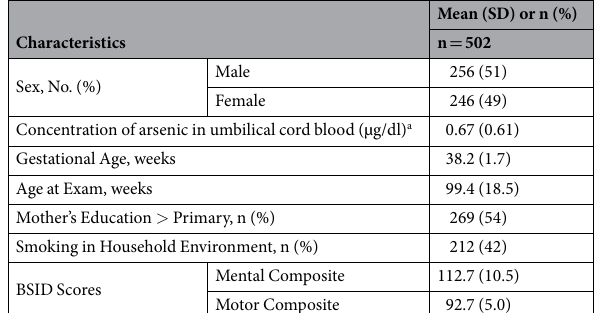
Table 1. Demographic, clinical, and neurological assessment data for Bangladesh cohort SD standard deviation. a There were 23 subjects in the Bangladesh cohort who did not have any recorded values for arsenic concentration.